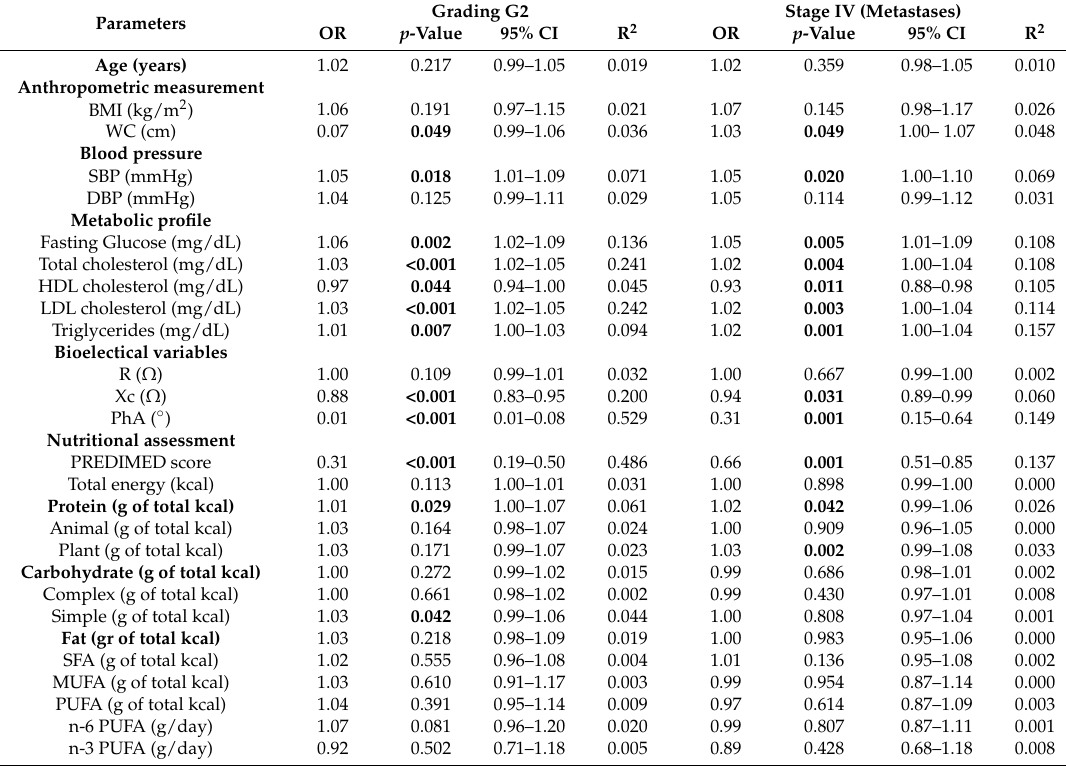
Table 5. Bivariate proportional odds ratio model performed to assess the association of tumor aggressiveness with demographic, clinical, metabolic, and bioelectrical